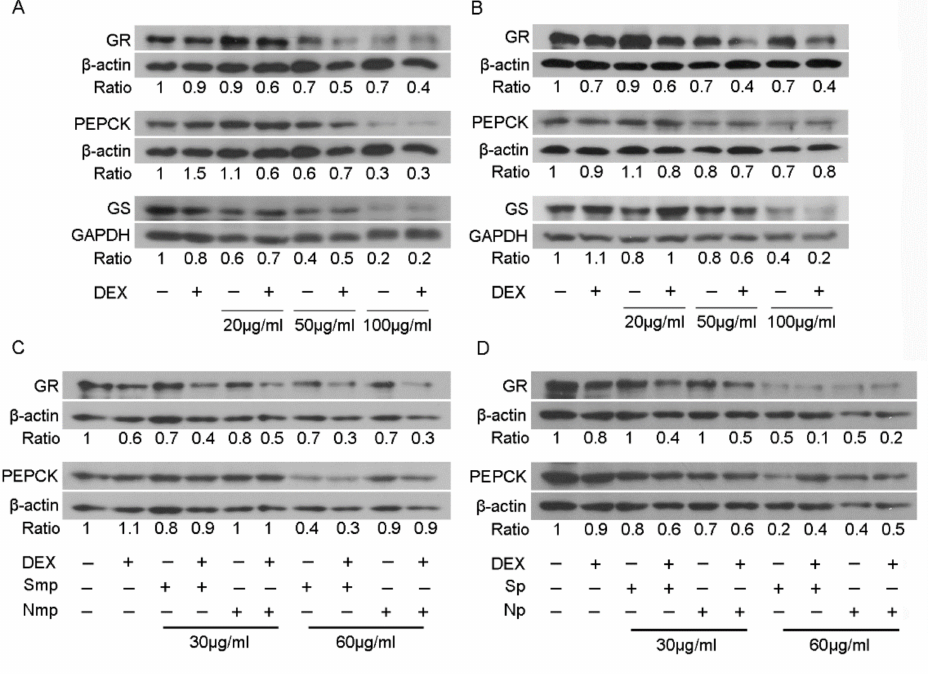
Figure 3. Effect of medium-polar ( A , C ) and polar ( B , D ) leaves fractions from mastiha trees grown in south ( A , B ) and south versus north ( C , D ) Chios on GR, PEPCK, and/or GS protein levels. Western blot analysis of GR, PEPCK, and GS protein levels in cell extracts from HEK293 cells treated with 20, 30, 50, 60, and 100 µ g/mL of leaves fractions and/or 10 nM DEX, for 48 ( C , D ) and 72 h ( A , B ) in hormone depleted medium, was performed using commercially provided antibodies. Ratios express normalization of bands intensity compared to the respective β -actin or glyceraldehyde -3-phosphate dehydrogenase (GAPDH)